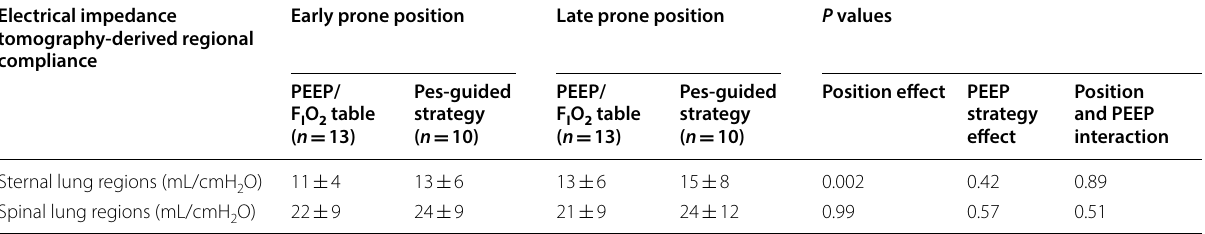
Values are mean